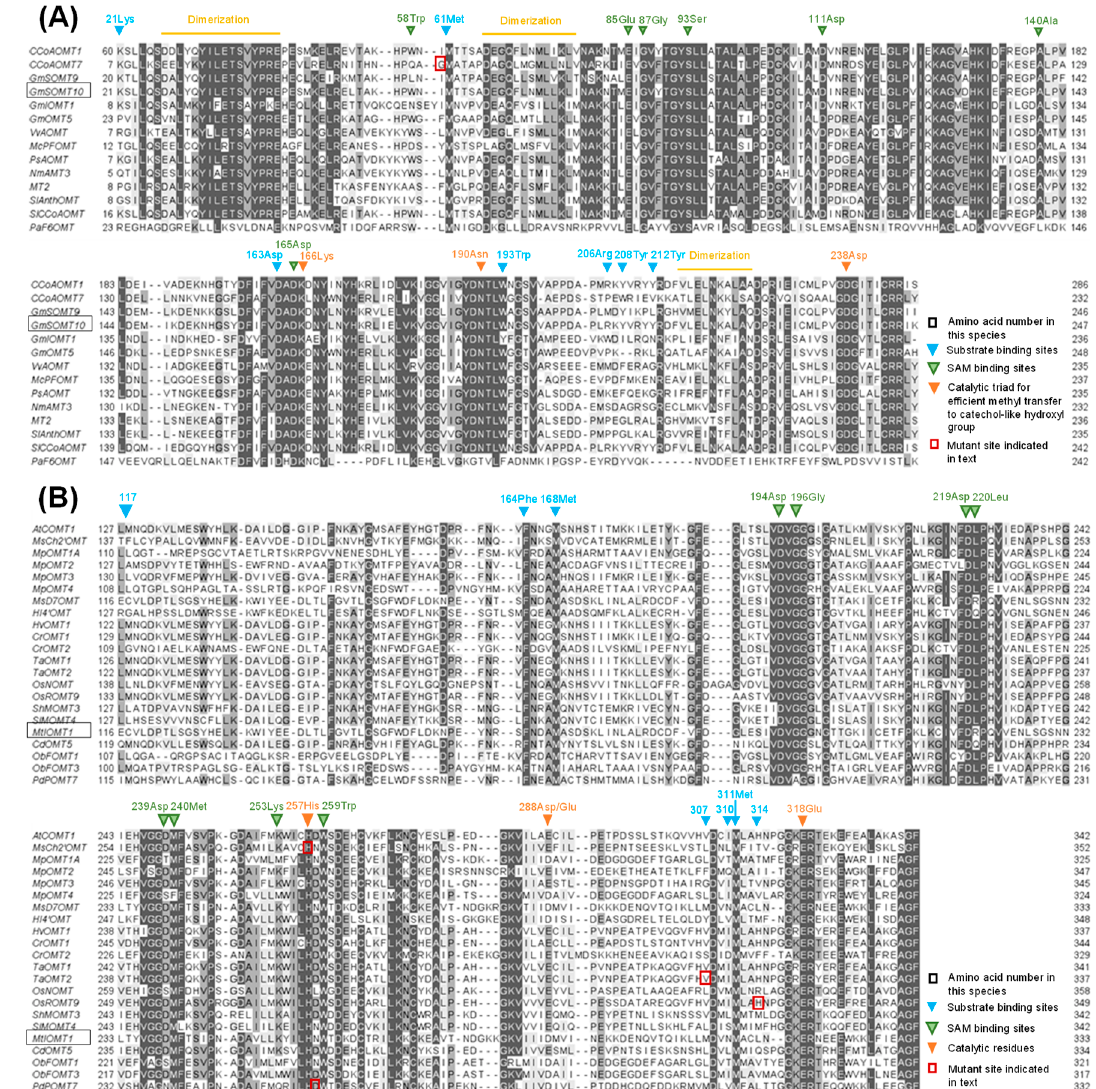
Figure 6. Multiple alignment of representative OMT genes. ( A ) Multiple alignment of class I OMT genes, including caffeoyl-CoA OMTs and anthocyanin OMTs. ( B ) Multiple alignment of class II OMTs, including caffeic acid OMTs, flavonoid OMTs and isoflavone OMTs. Blue inverted triangle indicates substrate binding sites, green inverted triangle indicates SAM binding sites, orange inverted triangle indicates catalytic residues, and red box indicates mutant site mentioned in this paper. Accession numbers shown in Figure